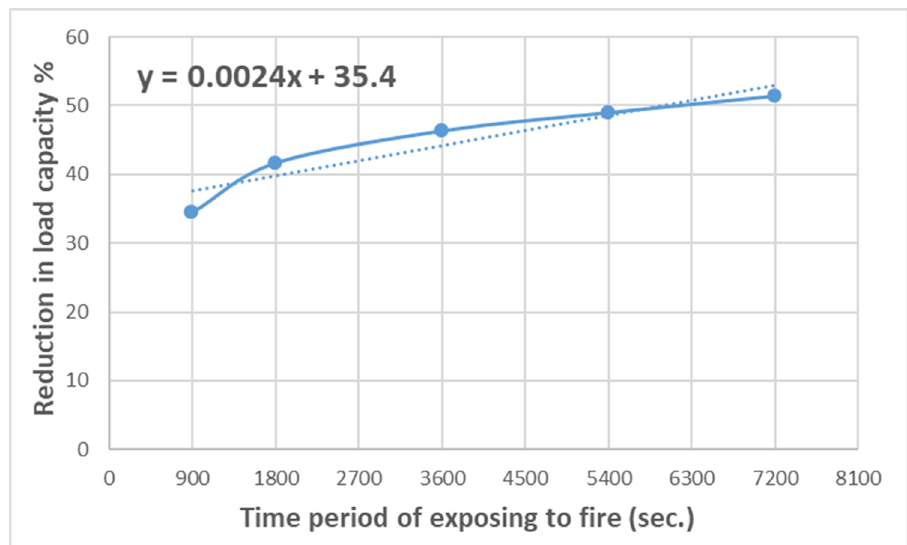
Figure 13: Reduction in load capacity due to fi re.